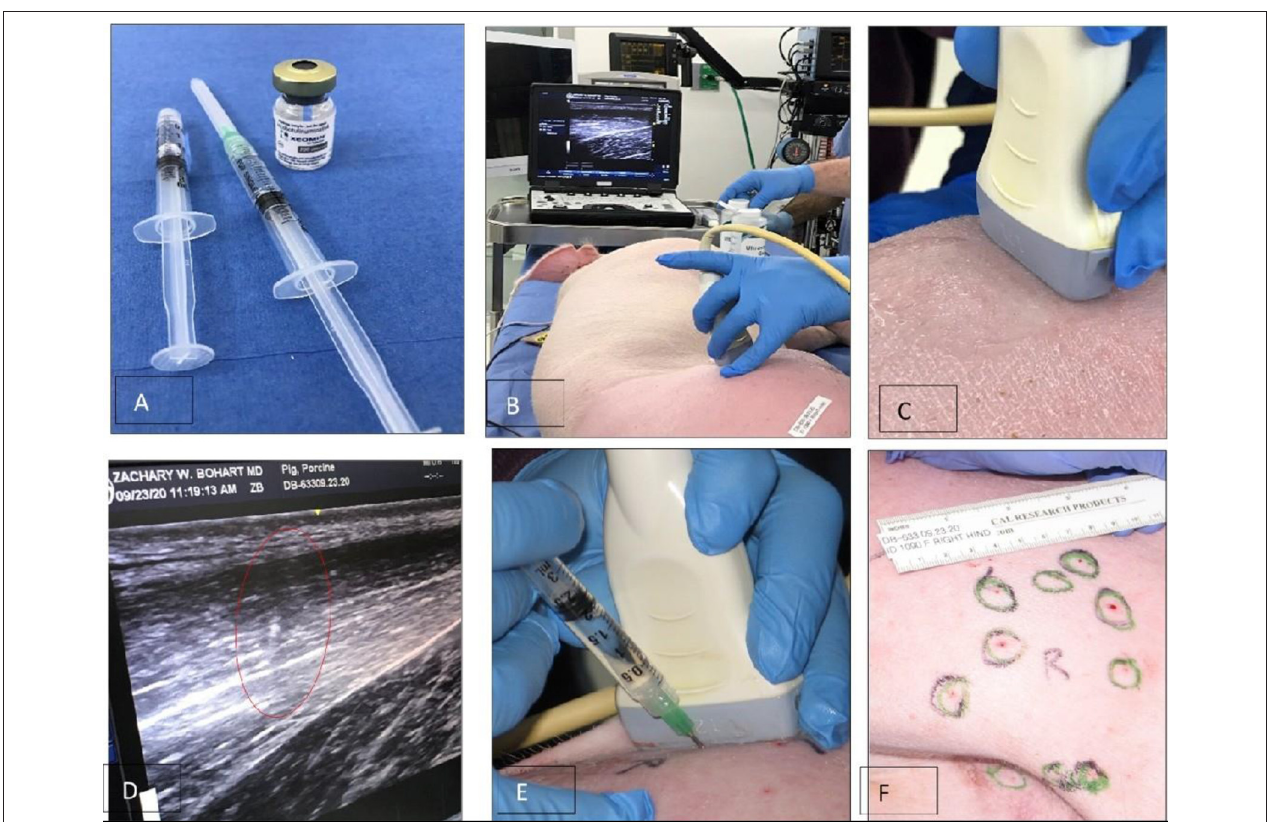
FIGURE 2 | A study on immobilizing skin and muscles before the osseointegration procedure for a better integration of tissues at the skin-implant (SBIP) interface. (A) Xeomin ® , an incobotulinum toxin A product equivalent to Botox ® and Dysport ® . (B) GE Ultrasound laptop machine for guidance of injections. (C,E) Finding a spot for injection with visual confirmation (D) . (F) Schematics of the injection spots in the study with the Animal 1-No. 1090, 9-23-20.